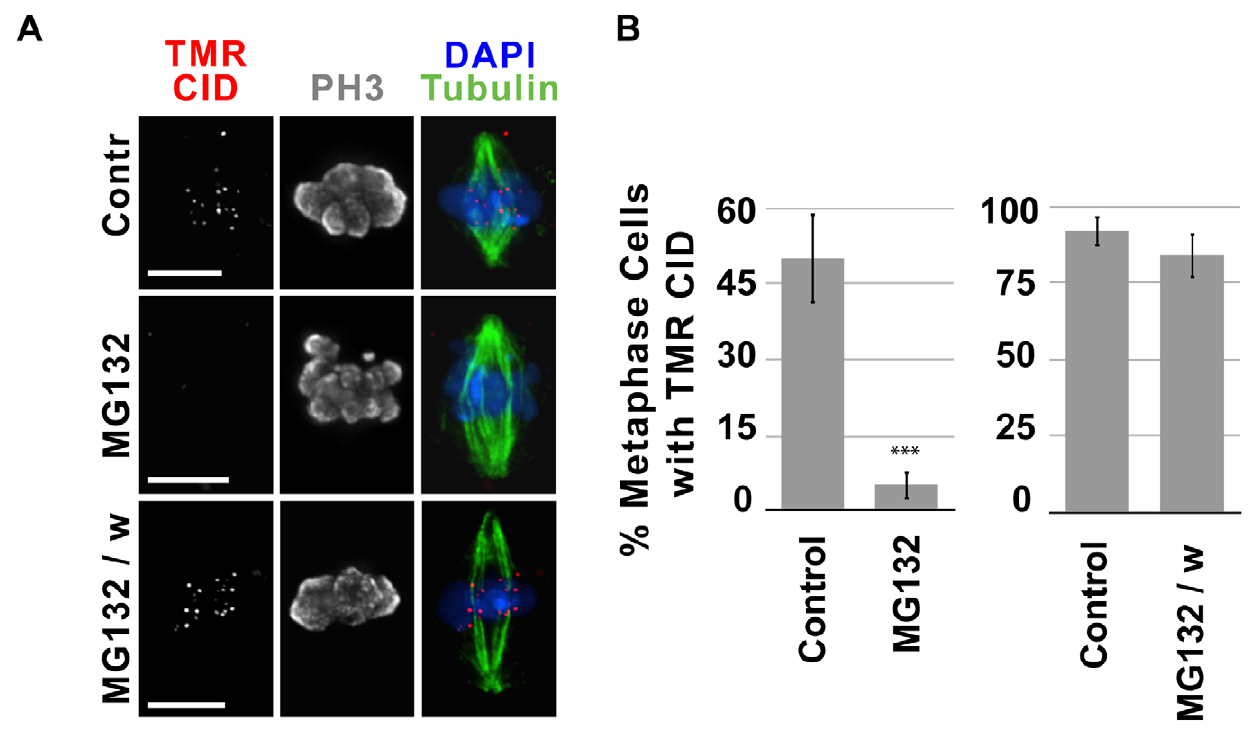
Figure 6. MG132 inhibition of the 26S proteasome suppresses recruitment of new CID. A) Representative images of untreated cells (Contr), cells treated with MG132 before and after BTP-block (MG132) and treated with MG132 prior to BTP block and washed with normal serum medium during chase (MG132/w). MG132 treatment blocked new CID loading, but this was reversible since removal of the drug by washing cells restores new CID loading. Tubulin is shown in green, phospho H3 in gray, TMR in red and DAPI in blue. Bar=5 m m. B) In independent experiments, untreated cells (control, n=29), cells treated with MG132 (n=37; left panel) and untreated cells (control, n=27) and MG132 treated cells followed by a chase without MG132 (n=25; right panel) were scored for the presence or absence of centromeric TMR-labeled CID. The percent of cells (y-axis) with visible centromeric new SNAP-CID decreased dramatically in the presence of MG132 (p , 0.0001, Fisher’s exact test).